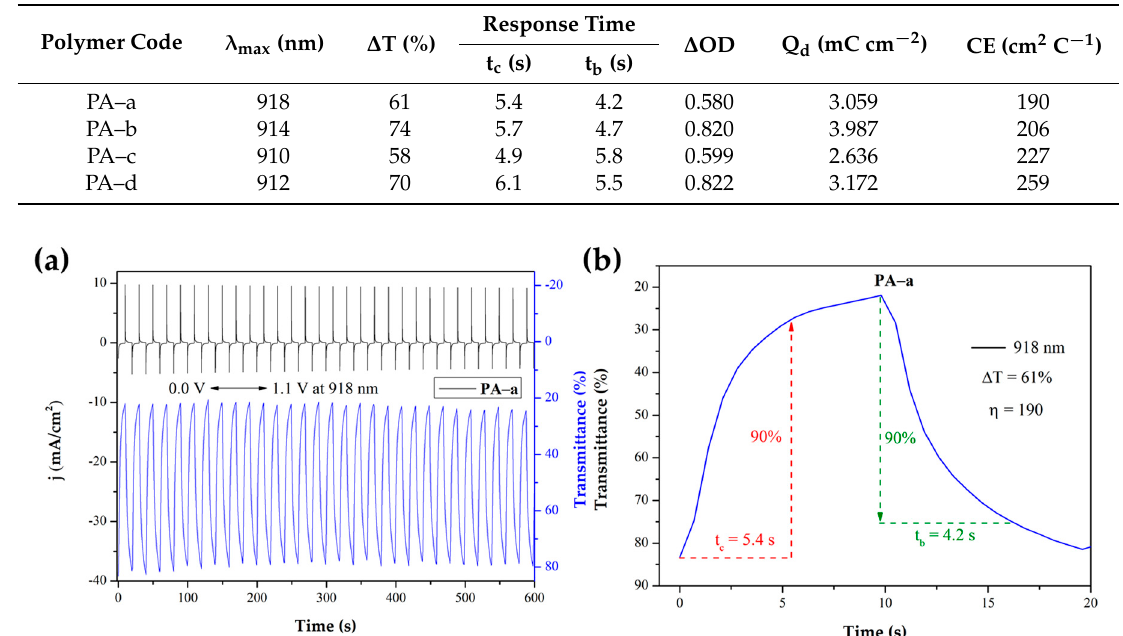
Figure 6. Dynamic changes of the transmittance and current ( a ) and optical switching ( b ) of PA–a. Table 4. Electrochromic properties of PAs.